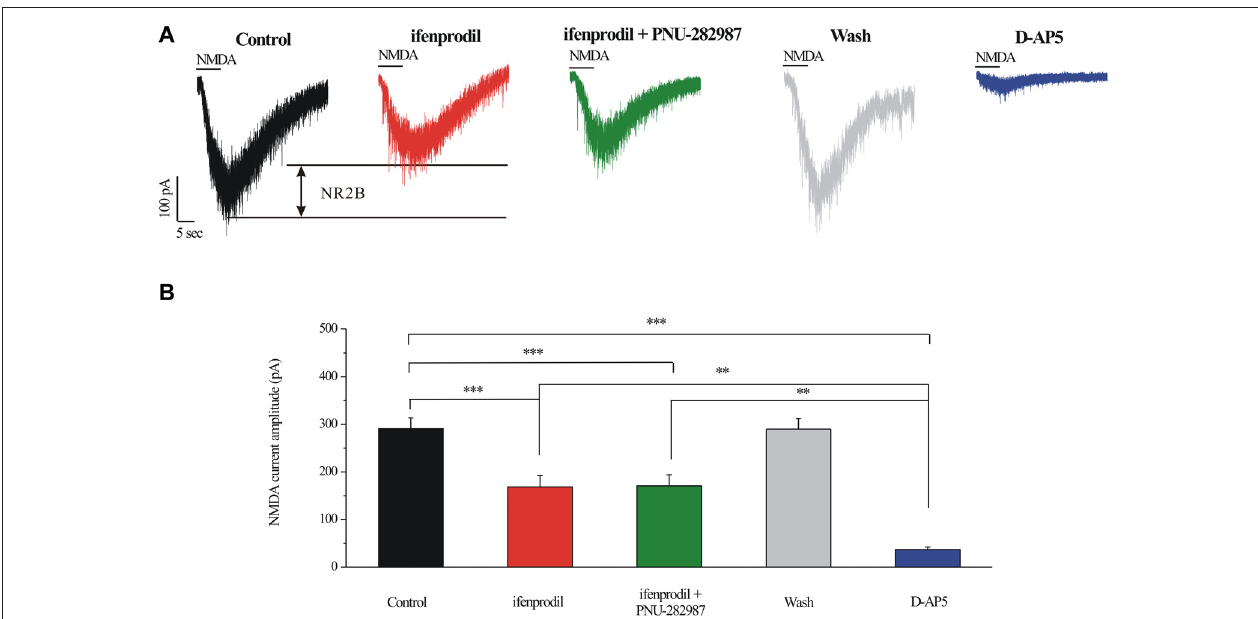
FIGURE 7 | Effect of ifenprodil, PNU-282987 and D-AP5 on NMDA-elicited currents in RGCs of the rat retina slice. (A) Representative NMDA-induced currents showing the amplitude of the NMDA-evoked currents (recorded in 0 Mg 2 + ACSF) in control, in the presence of 10 µ M ifenprodil, ifenprodil + PNU-282987, after washing out drugs and during D-AP5 (50 µ M). Vertical calibration bar, 100 pA; horizontal calibration bar, 5 s. (B) Summarized data of the amplitude of NMDA-evoked currents ( n = 6). ∗∗ p < 0.01, ∗∗∗ p < 0.001 (one-way analysis of variance). Holding potential was − 70 mV. The results are expressed as the mean ± standard